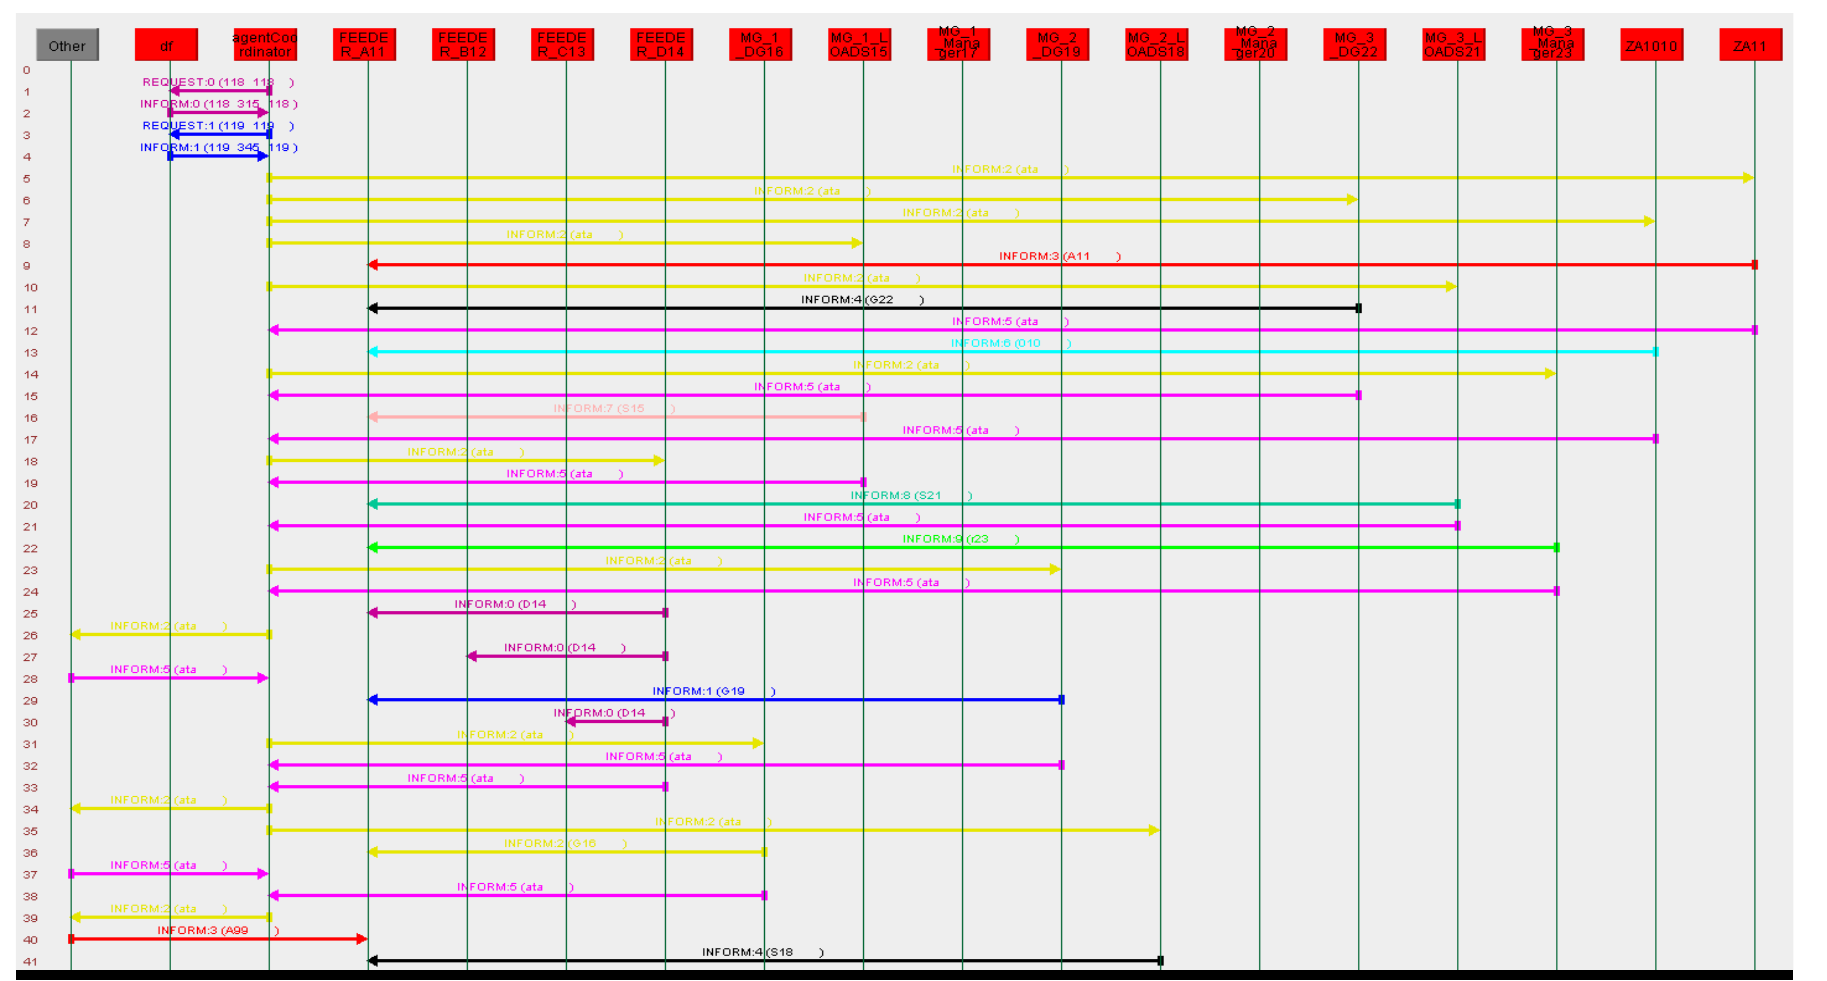
Figure 9. Messages transfer between system agents during CASE 5.